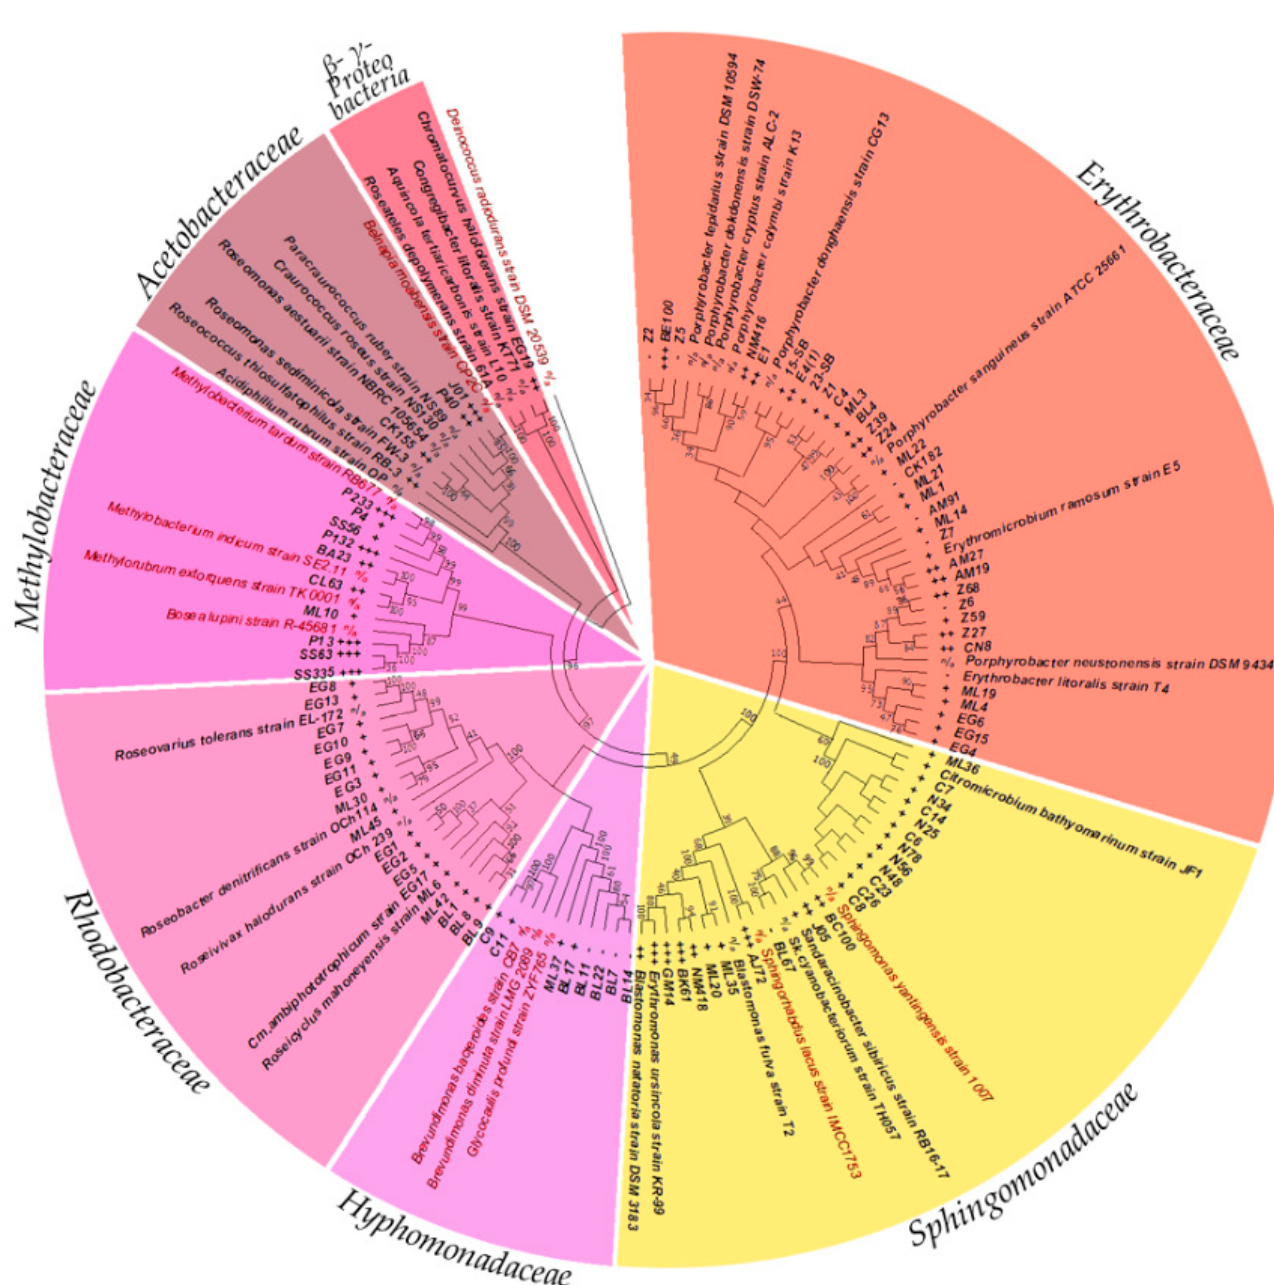
Figure 2. Phylogenetic tree of AAP tested for siderophore production. Isolates hailed from α -proteobacterial families Erythrobacteraceae , Sphingomonadaceae , Acetobacteraceae , Rhodobacteraceae , Hyphomonadaceae and Methylobacteraceae , as well as a representative within the γ - subclass of Proteobacteria (titled sections around circumference of circle). Fe-chelation siderophore activities are listed between strain names and phylogenetic position. Strain names in bold are confirmed AAP, red highlighted are not.